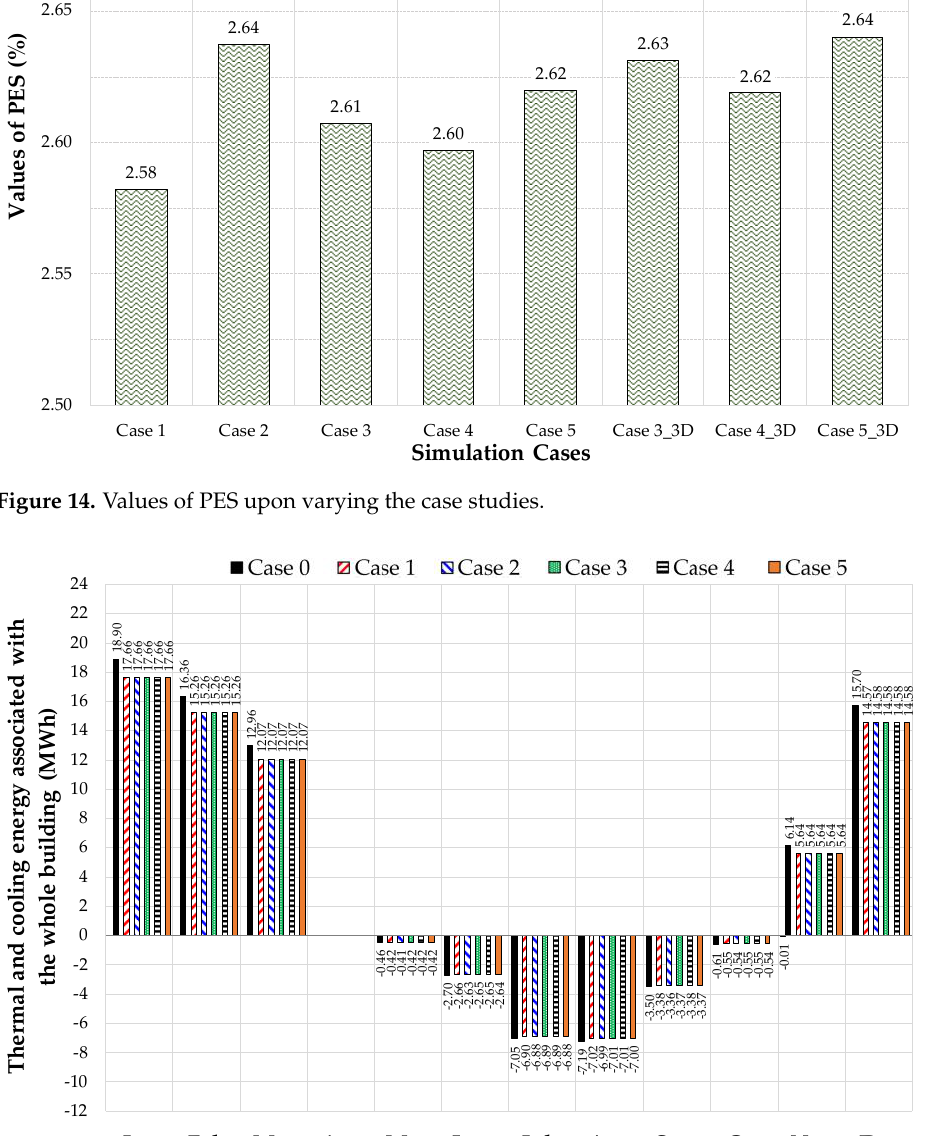
Figure 15. Main energy flows of the building during the whole simulation period associated with Case 0, Case 1, and retrofit Cases with extruded panels.